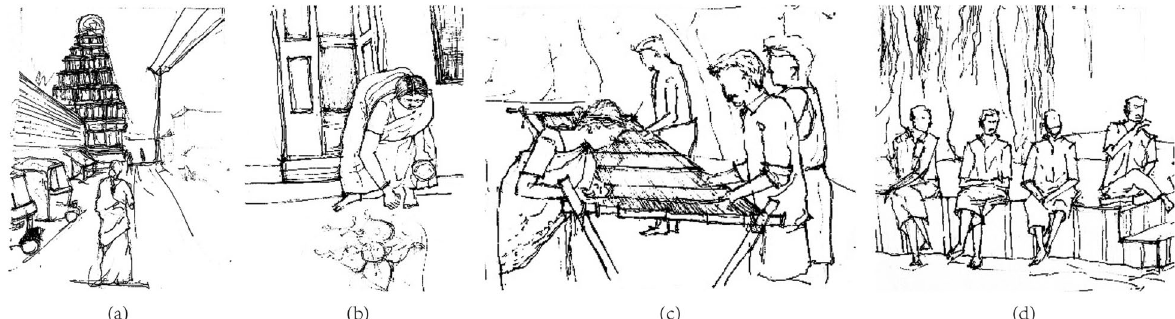
Fig. 9 a Temples are the prime focus of daily activities of the community, b morning ritual of applying ‘kolam’ (design on ground made with rice flour) in front of the residences, c the street sizing activity, d social gathering spaces in the form of a raised seating under a tree (Source: the